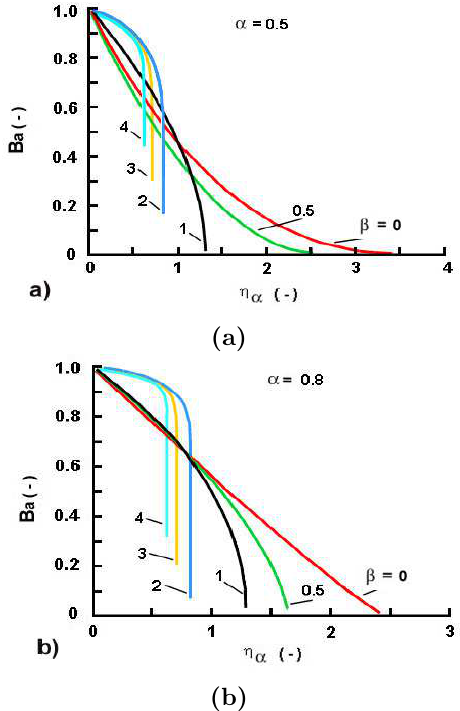
Figure 6. DIM solutions to the mag- netization of field-dependent material with time-dependent boundary condi- tion and optimal exponents [16] show- ing how the value of the exponent β deforms the solution profile towards a rectangular wave with sharp front: a) Case with α = 0 . 5 , b), case with α = 0 .